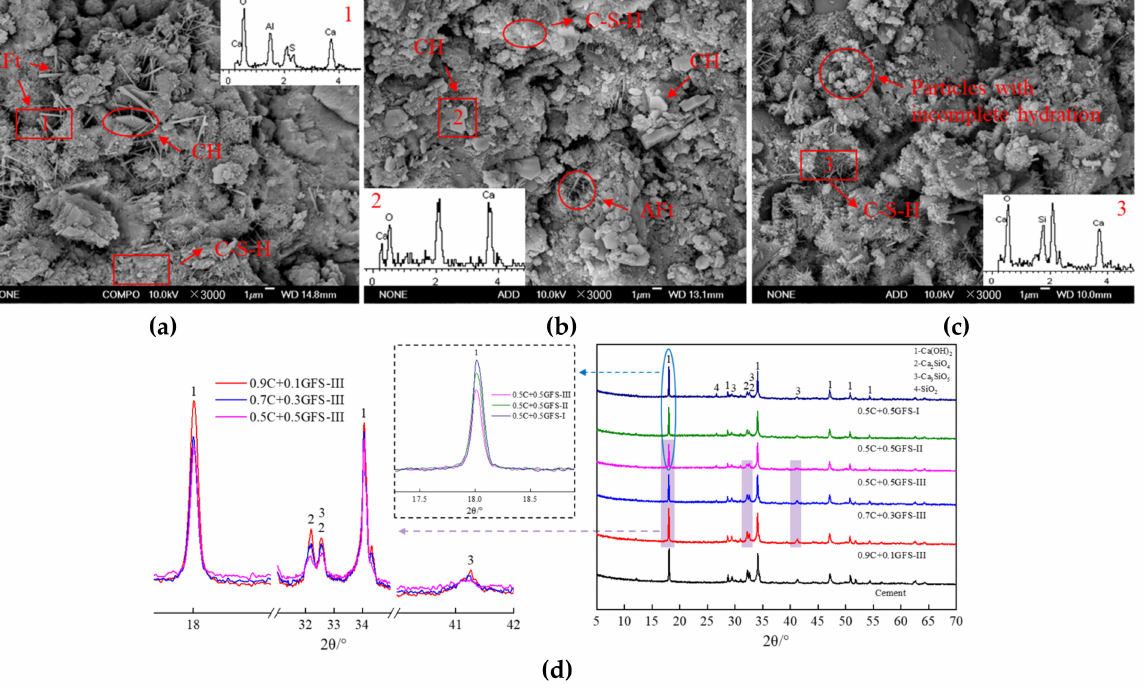
Figure 13. Microstructures and compositions of the hydrated products of the GFS-blended cement pastes after their hardening for 3 d. ( a ) Cement, ( b ) 0.9Cement+0.1GFS-III, ( c ) 0.5Cement+0.5GFS-III, ( d ) XRD patterns of the materials hardened for 3